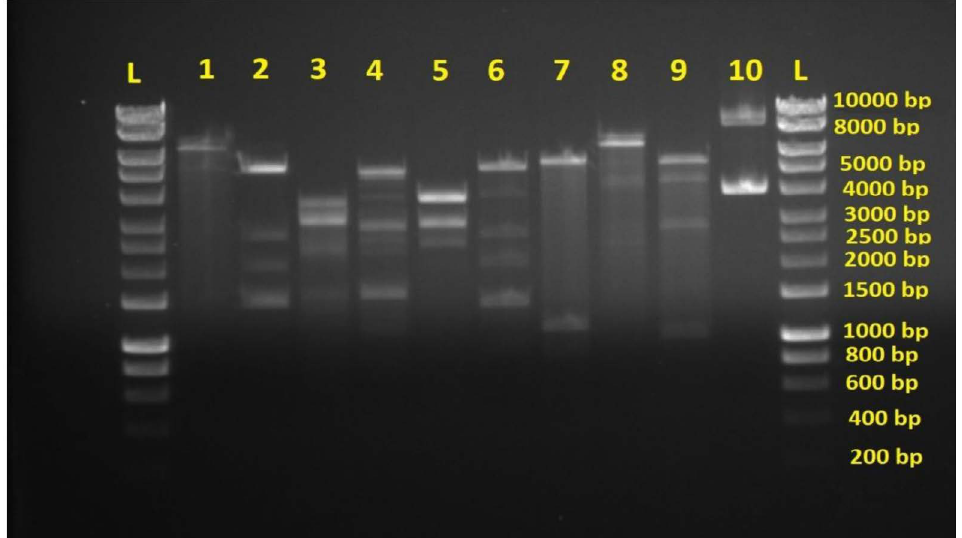
Fig. 1. Agarose gel electrophoresis of plasmids digested by BamHI and HindIII endonucleases. L is hyperladderI. Lane 1-10 are double digested plasmid samples from different E.coli isolates showing DNA variations. Lanes 2,3,4,5,6 and 9 show more DNA bands indicating more DNA diversity. Lanes 1,7,8, and 10 show less DNA bands indicating less DNA